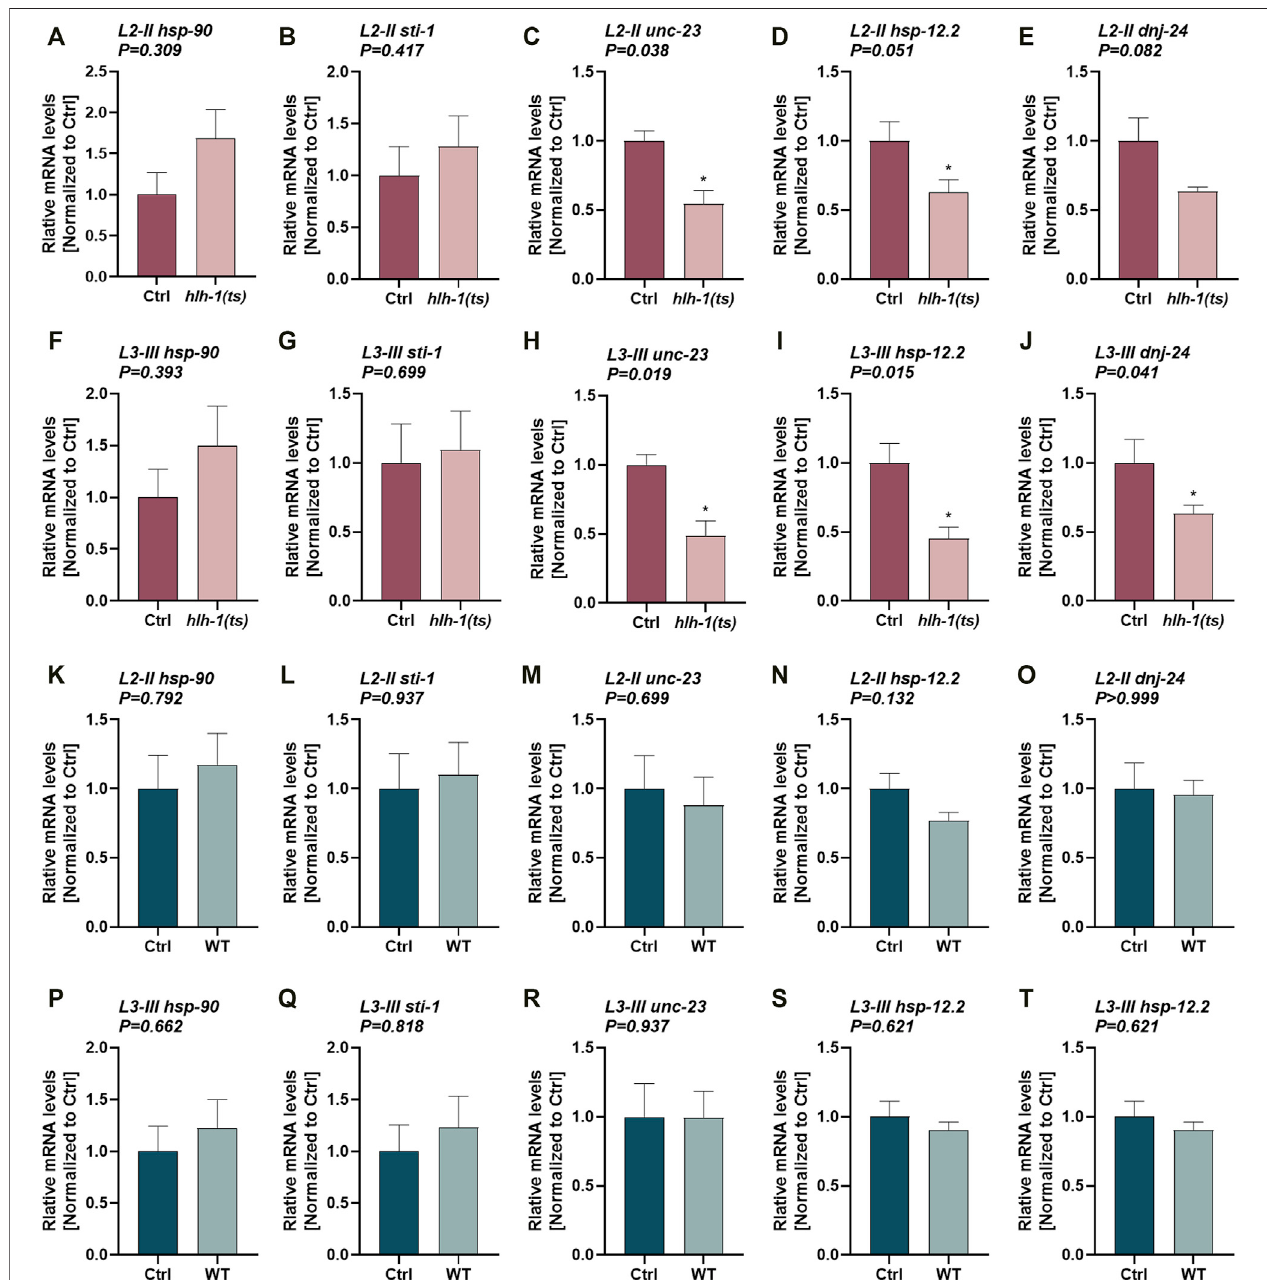
FIGURE 3 | The expression of HLH-1-dependent chaperones during larval development. (A – T) Expression levels of chaperones in hlh-1(ts) animals. Relative mRNA levels of HLH-1-dependent chaperones, hsp-90 , sti-1 , unc-23 , hsp-12.2 , or dnj-24 , in age synchronized hlh-1(ts) (A – J) or WT (K – T) animals, shifted to 25 ° C at L2-II[ (A-E) and (K-O) ]orL3-III[ (F-J) and (P-T )]larvalstages.Expressionlevelswerecomparedwiththesamestrainanimalsmaintainedat15 ° C(Ctrl).Dataaremeans± 1standarderrorofthemean(1SE).DatawereanalyzedusingtheWilcoxonMann-WhitneyranksumtestcomparedwiththesamestrainCtrltreatedanimals(N ≥ 4).